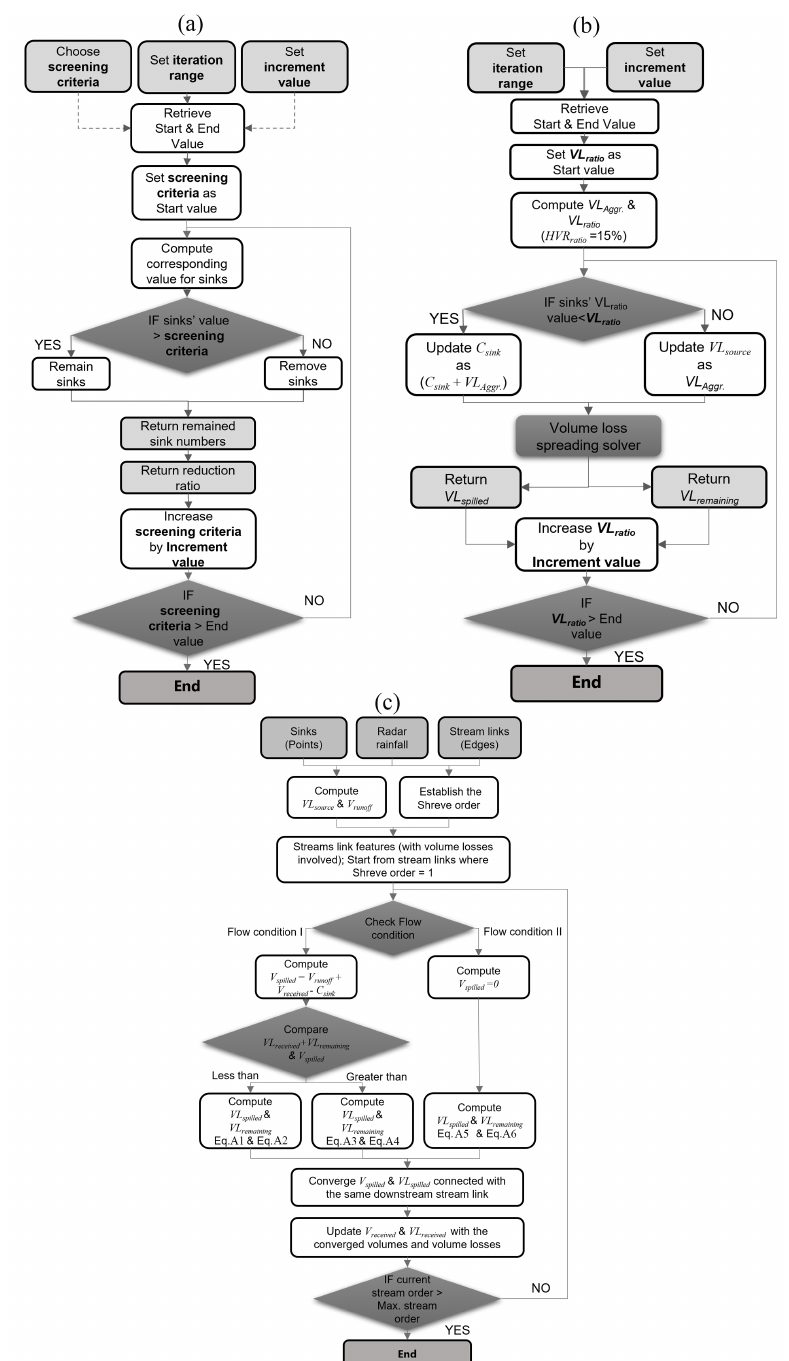
Figure A1. ( a ) Iteration procedures for the total number of sink reductions when using different screening criteria: (i) maximum depth, (ii) volume and (iii) HRV ratio . ( b ) Iteration procedures of the volume loss reductions when using VL ratio . ( c ) The volume loss spreading solver’s workflow, where light grey boxes represent inputs and outputs of procedures; dark grey boxes stand for the major steps and bold fonts represent variables. Equations (A1)–(A6) are provided in Appendix